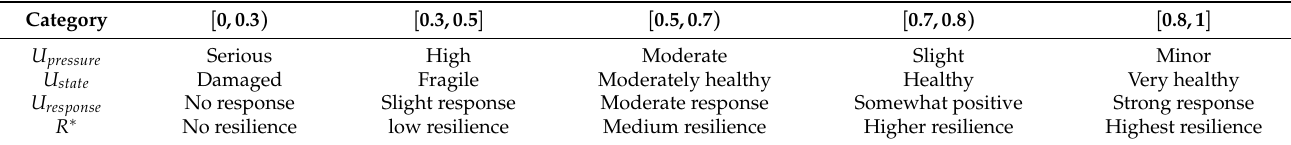
Table 1. Classification of urban infrastructure resilience